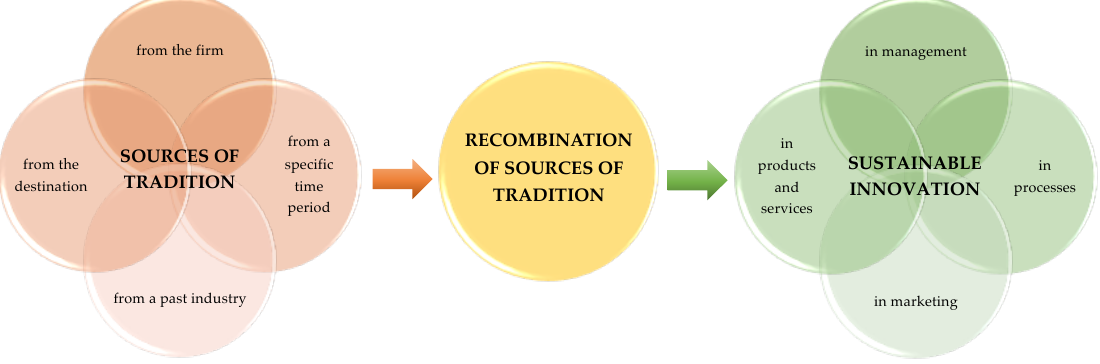
Figure 4. Conceptual model: The process of sustainable innovation through a tradition-based